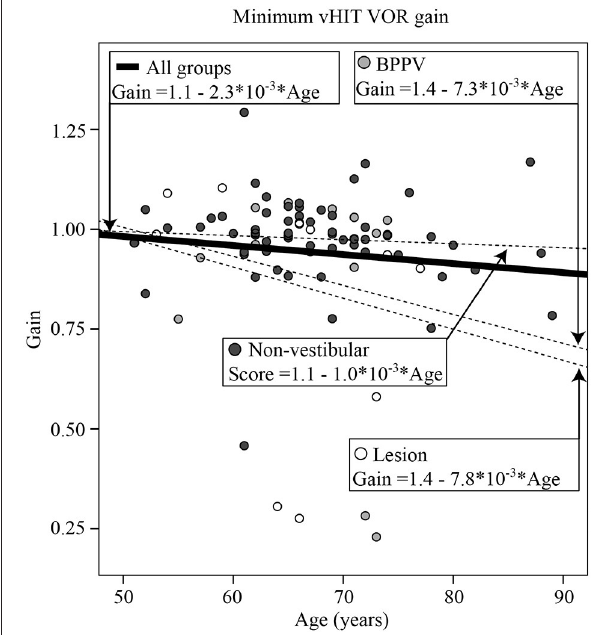
FIGURE 2 | Minimum (between leftward and rightward head rotations) video Head Impulse Test (vHIT) vestibulo-ocular reflex (VOR) gain calculated for each participant vs. their age, clustered by group with group and overall